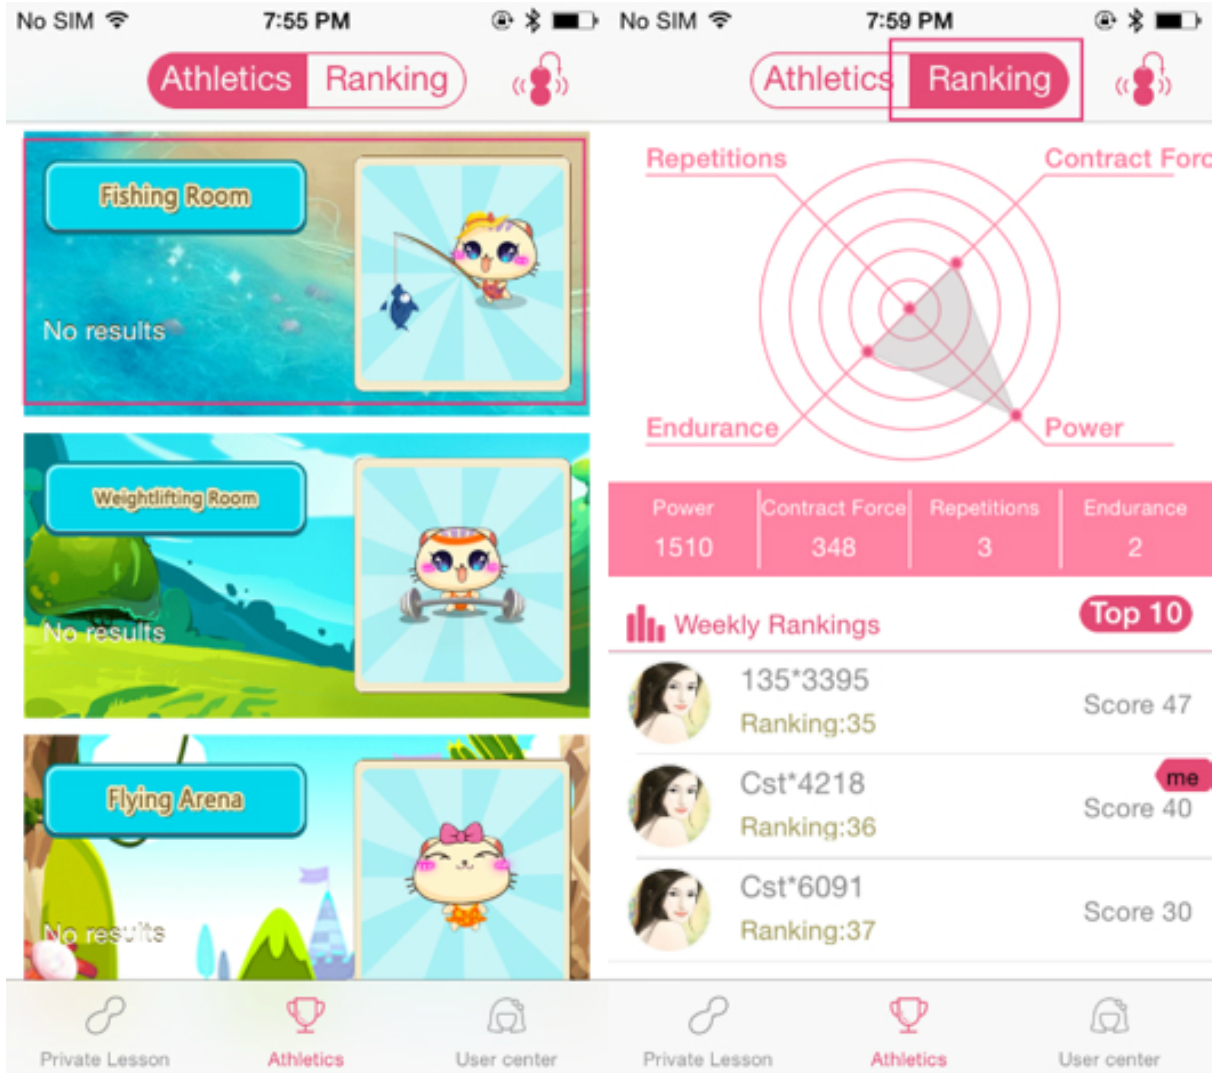
Figure 2. The iBall App. Left: There are a number of activities that aid in engaging the pelvic floor. Right: The progress of the user can be tracked and